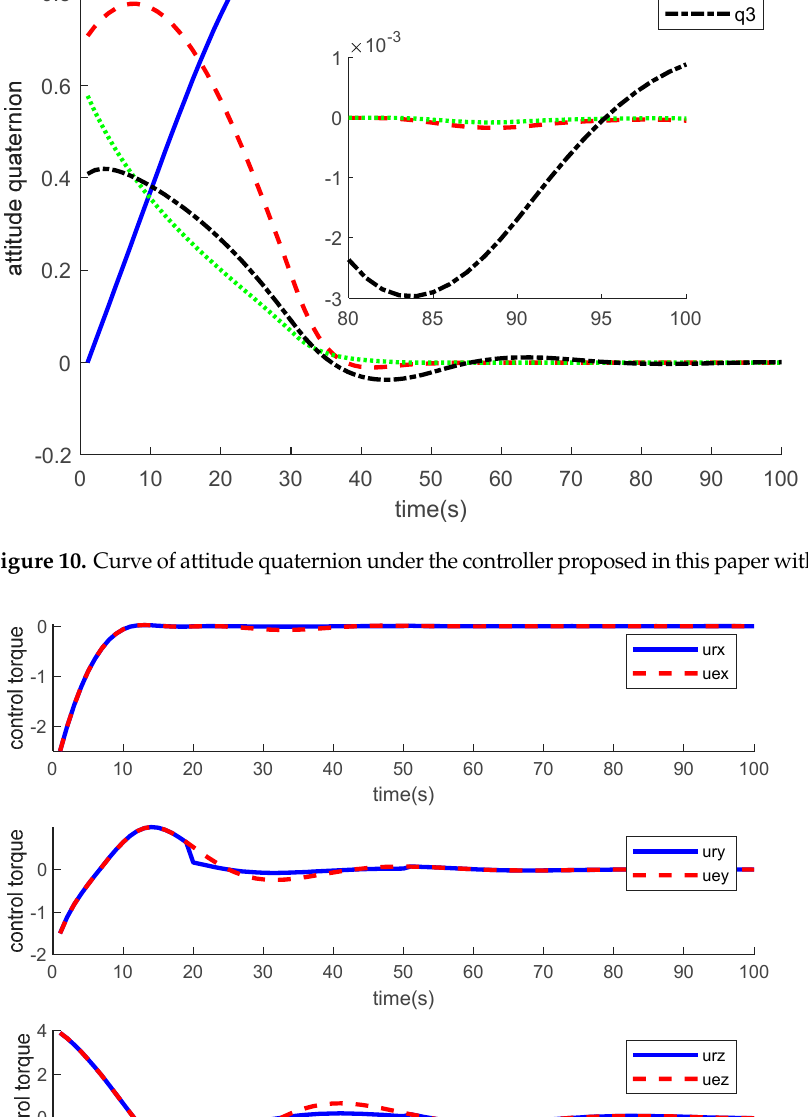
Figure 11. Control torque of the proposed controller with actuator failure and without actuator failure.